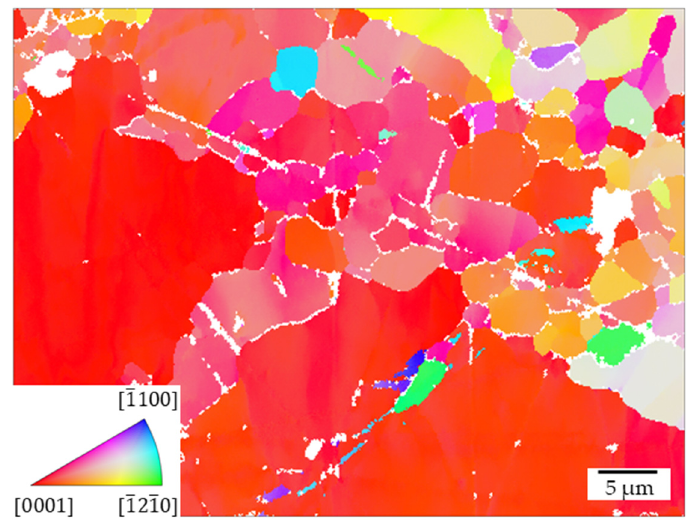
Figure 15. EBSD measurement of the transformed AZ31 magnesium alloy point II (300 °C, 0.01 s − 1 ): former twins that recrystallized, typical TDRX.